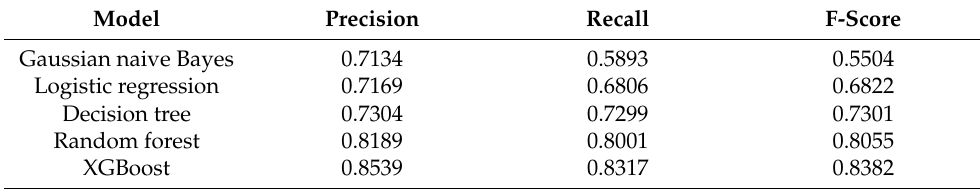
Table 6. Performance results for different machine learning